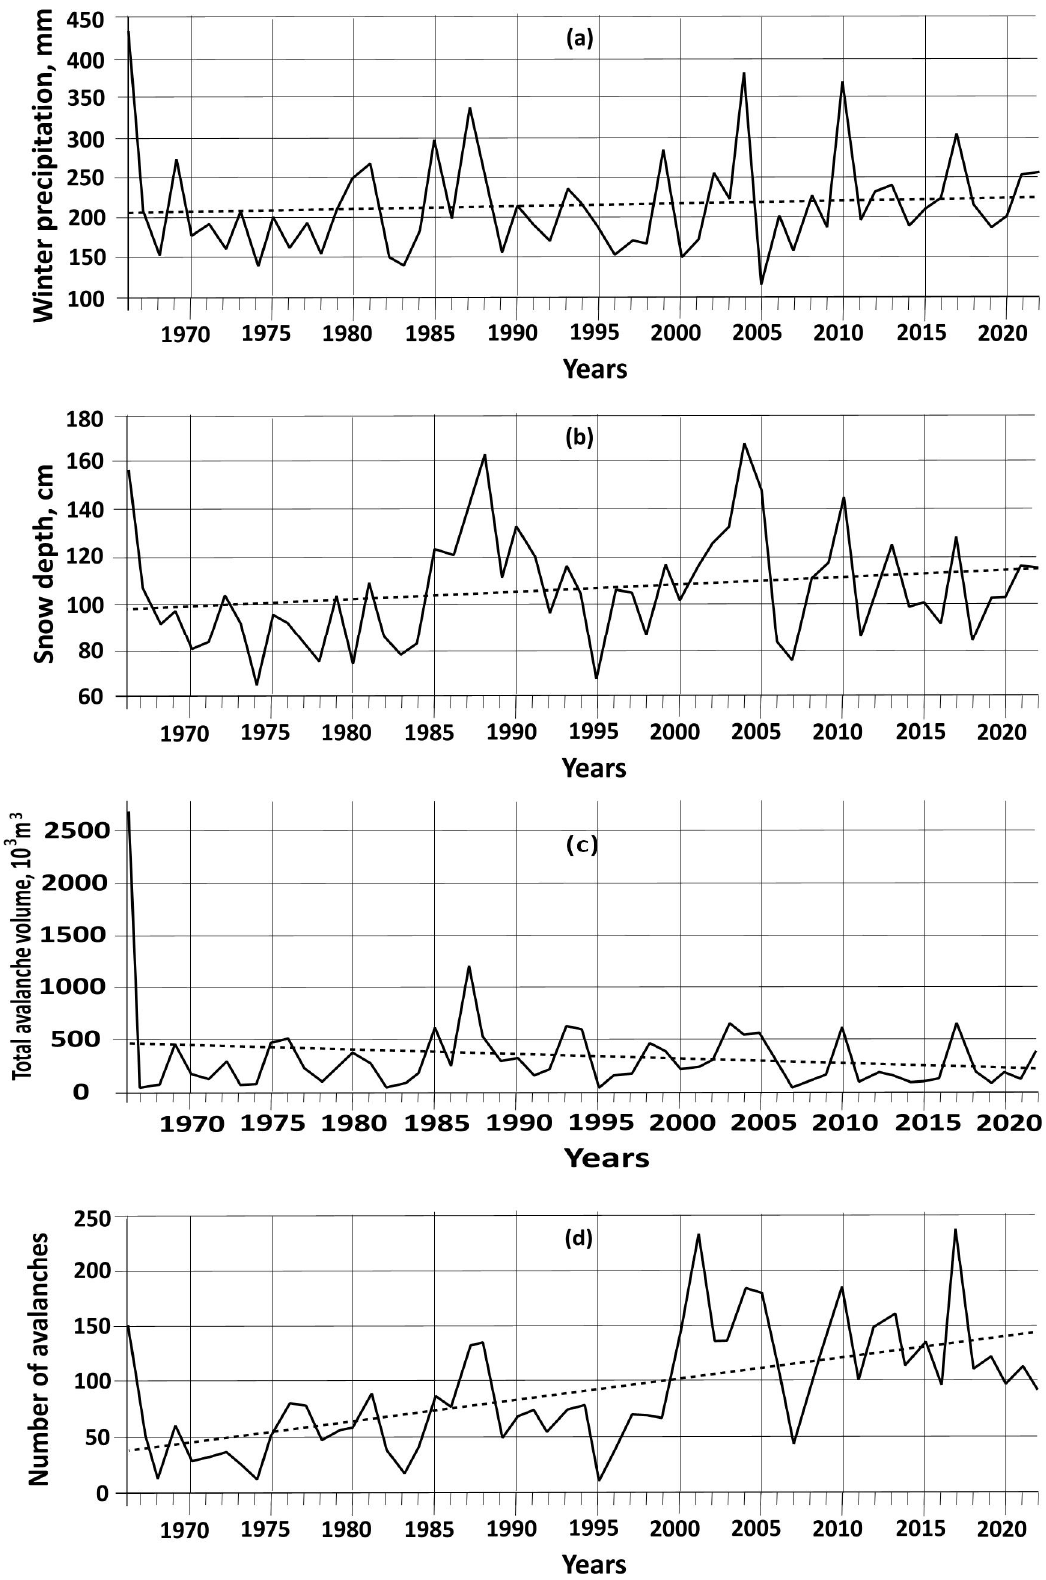
Figure 5. The interannual variability and the long-term temporal trends (dotted line) of snowiness and avalanche activity indices: ( a ) winter precipitation, ( b ) snow depth, ( c ) total avalanche volume, ( d ) number of avalanches.